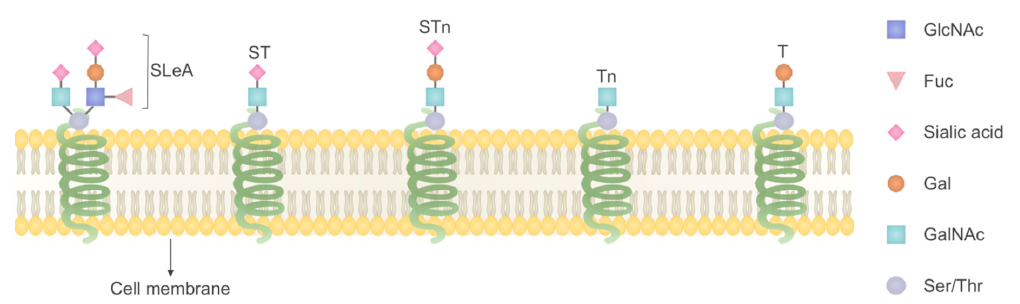
Figure 2. Glycan alteration in GI cancer, one common feature of GI cancers is the overexpression of Tn antigen (GalNAc α 1-Ser/Thr), T antigen (Gal β 1-3GalNAc α 1-Ser/Thr), STn (Neu5Ac α 2- 6GalNAc α 1-Ser/Thr), ST (Neu5Ac α 2-3Gal β 1- 3GalNAc α 1-Ser/Thr) and also sialyl-Lewis A